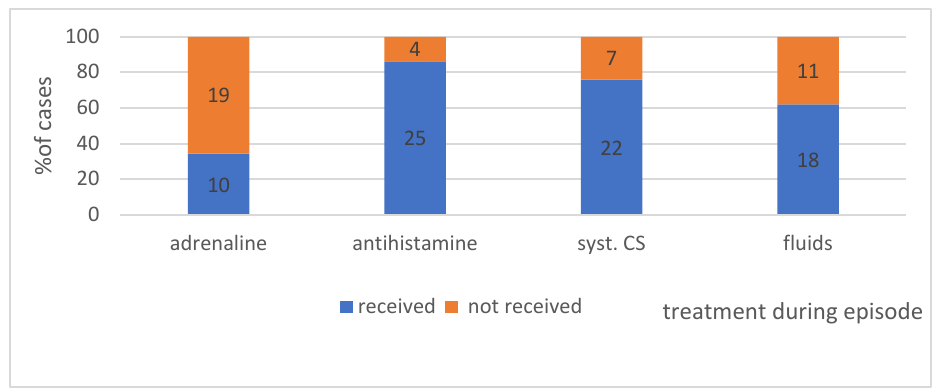
Figure 9. The treatment applied or lack thereof in the study group. Absolute values of numbers of patients are given in the diagram.